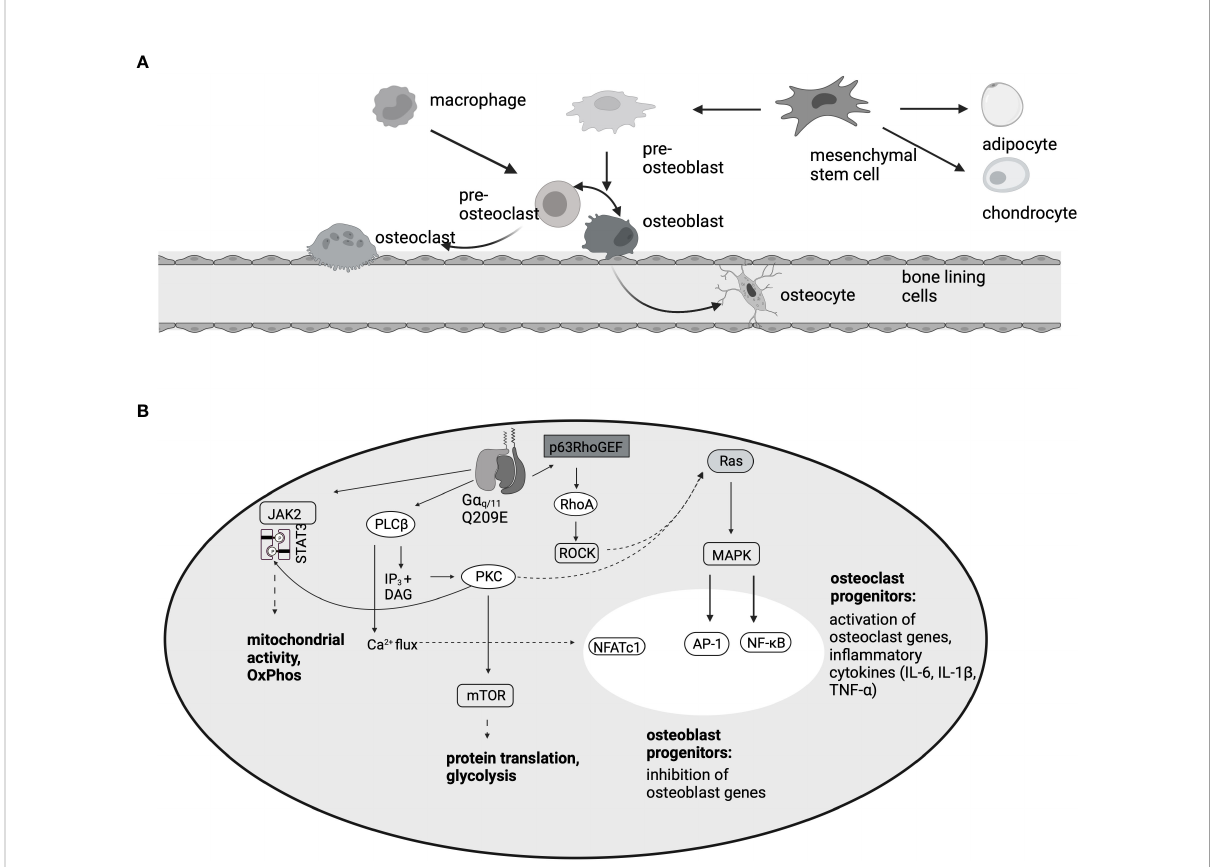
FIGURE 3 PMT-mediated effects in the bone. (A) Osteoblasts, like chondrocytes and adipocytes, develop from mesenchymal stem cells. Osteoclasts are haematopoietic cells that develop from macrophage/monocyte precursors. This is mediated by the two cytokines M-CSF and RANKL. Because RANKL is expressed on osteoblasts, there is a direct interaction between the two cell types. (B) Summary of the pathways involved in osteoclast differentiation and inhibition of osteoblastogenesis, according to data published by (35, 85, 112, 113). In osteoclast progenitors, activation of the transcription factors NFATc1, AP-1 and NF- k B results in osteoclast gene transcription, however, in osteoblast progenitors, MAPK activation inhibits the induction of osteoblast differentiation